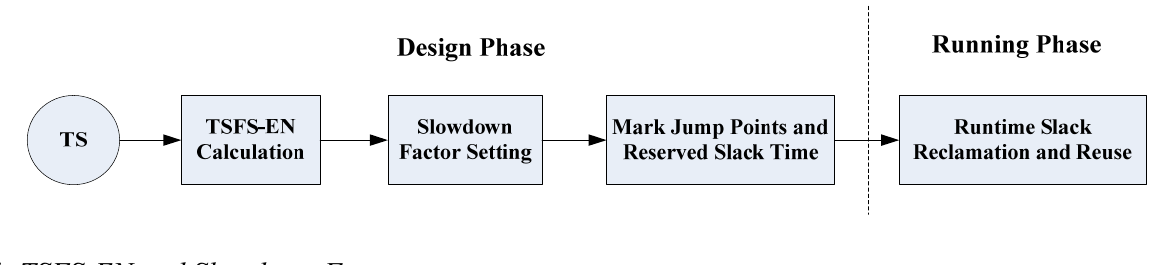
Figure 2. Process of assigning tasks’